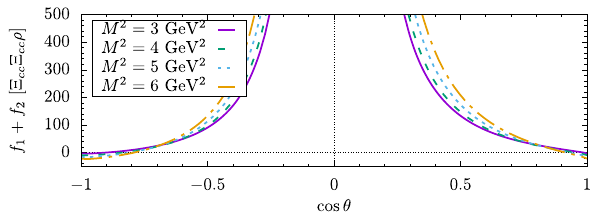
Fig. 3 The dependence of the coupling constant f 1 + f 2 for Ξ cc Ξ cc ρ on cos θ for the shown values of M 2 and at